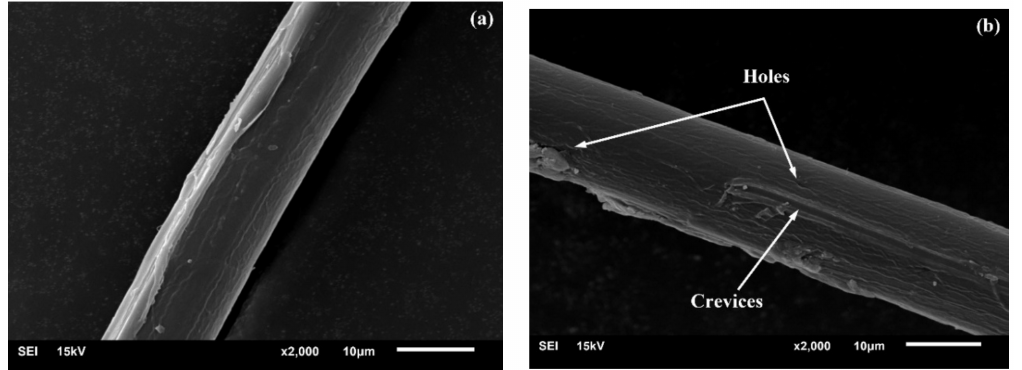
Figure 4. SEM images of surface morphology of an elementary fiber: ( a ) before alkali treatment; and ( b ) after alkali